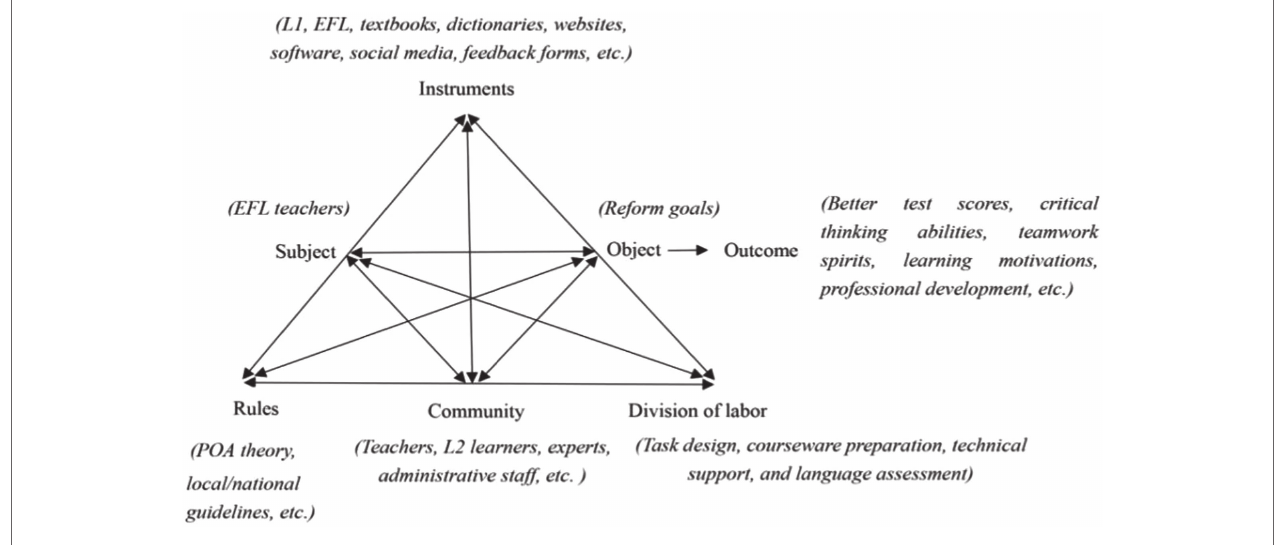
FIGURE 2 | Activity theory as an interpretive framework for teacher activities in